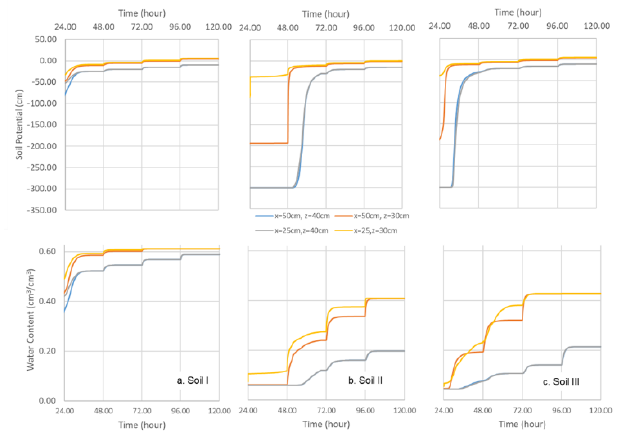
Fig. 10 Numerical simulation results of 2 dimensions of automatic irrigation at setpoints: 10cm, 15cm, 20cm, 25cm, and 30cm for Soil I (left), Soil II (middle), and Soil III (right); presented in pressure head (top) and water content (bottom). Observed at the 50 cm and 25 cm between